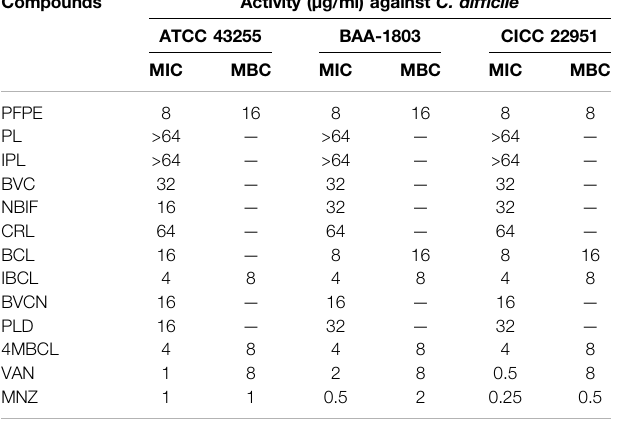
TABLE 2 | The MIC and MBC of test samples against C. dif fi cile . Compounds